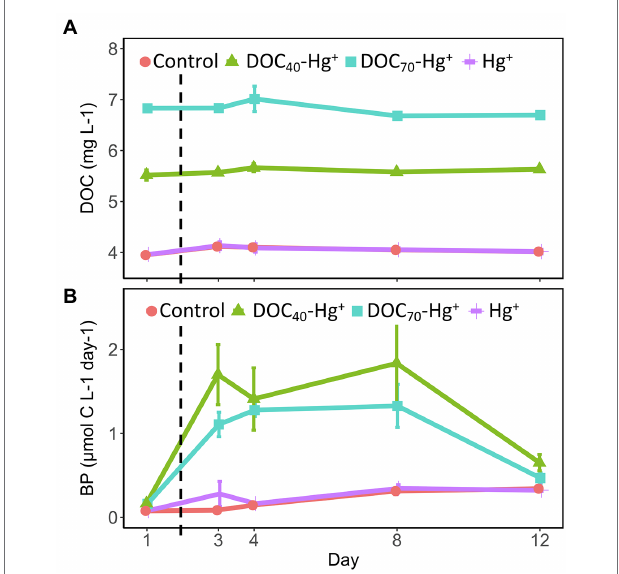
FIGURE 1 | Concentration of dissolved organic carbon (A) and bacterial production (B) in the different treatments throughout the experiment. The dashed line indicates the addition of Hg(II). Error bars represent the standard error ( n =